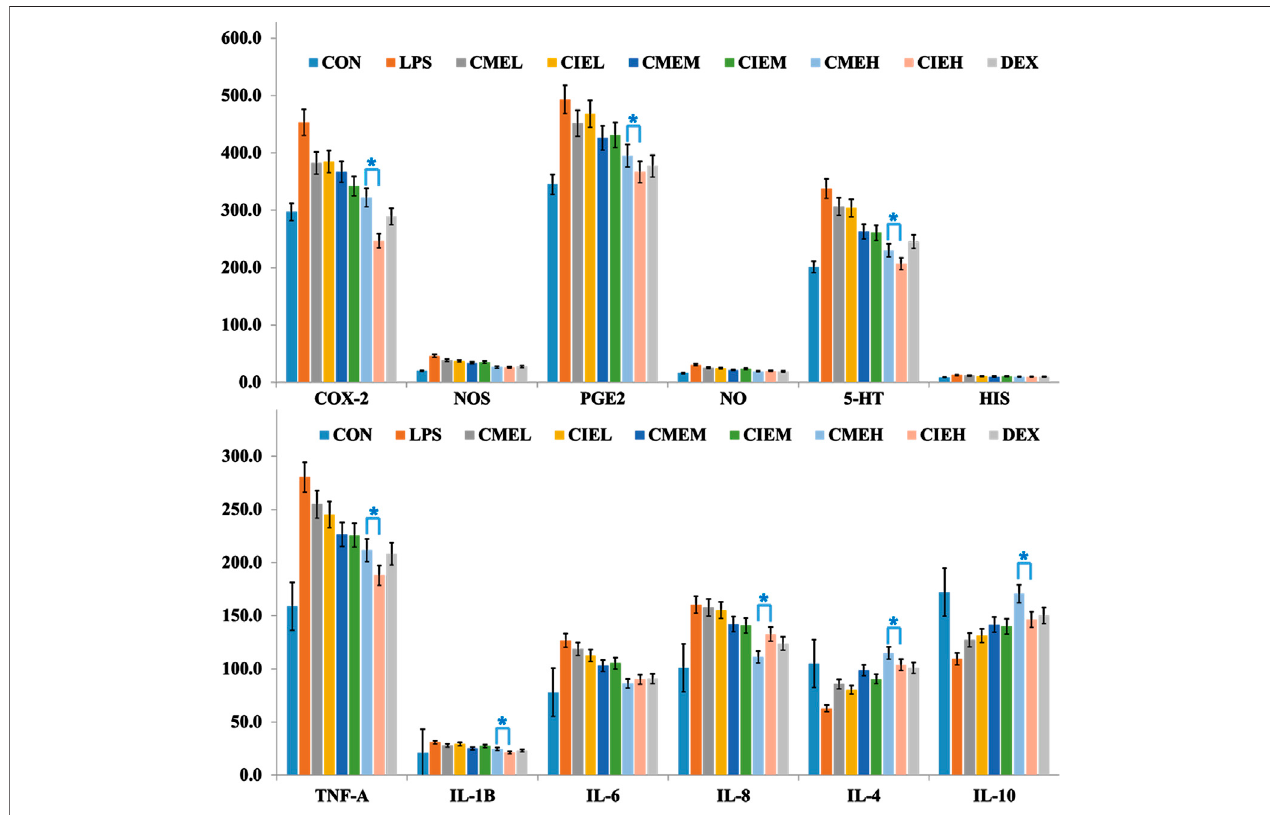
FIGURE 3 | Anti-in fl ammation effect of C. morifolium fl ower extract (CME) and C. indicum fl ower extract (CIE) in lipopolysaccharide-induced rats. The data are expressed as the mean ± S.D. The signi fi cant difference between groups of CME and CIE with different dose was statistically evaluated, respectively, by the Student ’ s t -test (* p <